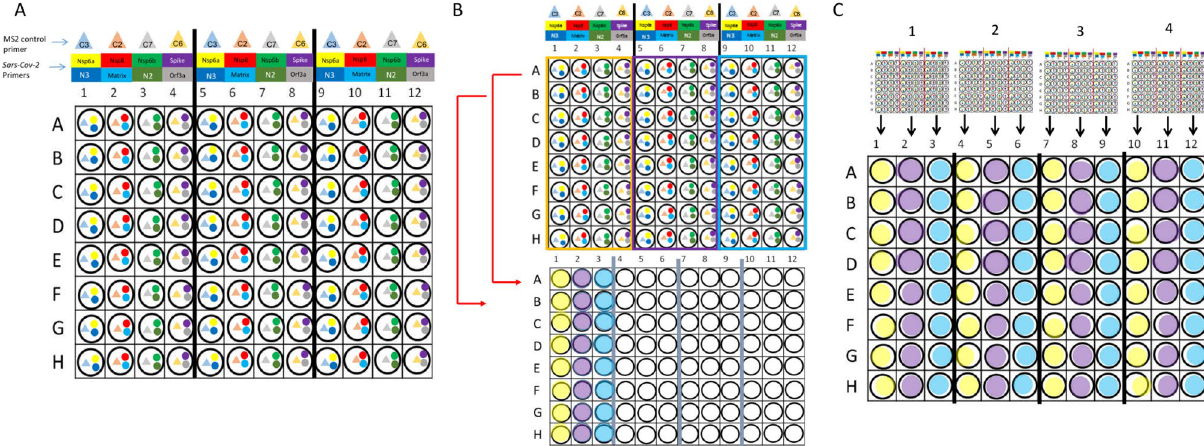
Figure 5. General scheme of how samples are processed in PCR and library plates ( A ) Each sample is individually amplified with a multiplex combination of primers for two SARS-CoV-2 targets and one MS2 control. ( B ) Every four columns of the PCR plate will be transformed into one column for the library plate. ( C ) Four complete PCR plaques (384 samples) generate one library plaque (96 individual sequencing libraries). Created with Microsoft Power